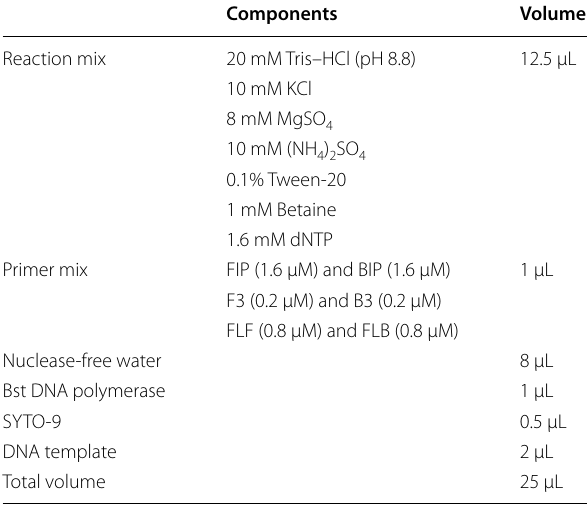
Table 3 Composition of the real‑time fluorescence LAMP reaction